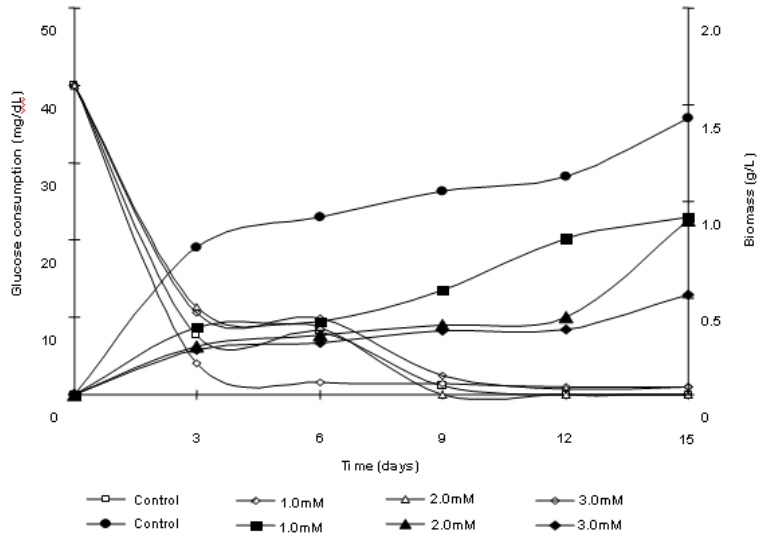
Figure 2. Trichoderma harzianum biomass production and glucose consumption in response to cadmium exposure.